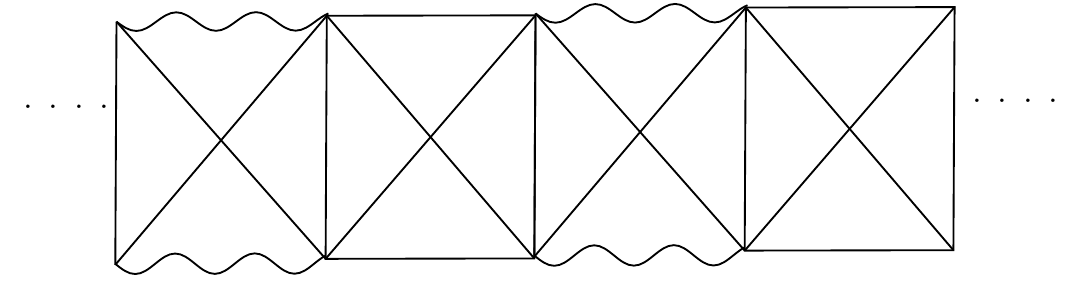
Figure 8 . Region of the Penrose diagram of dS covered by one set of Kruskal coordinates.